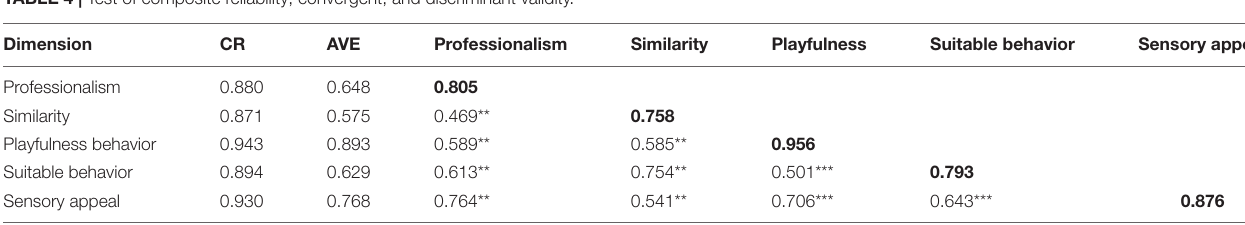
TABLE 4 | Test of composite reliability, convergent, and discriminant